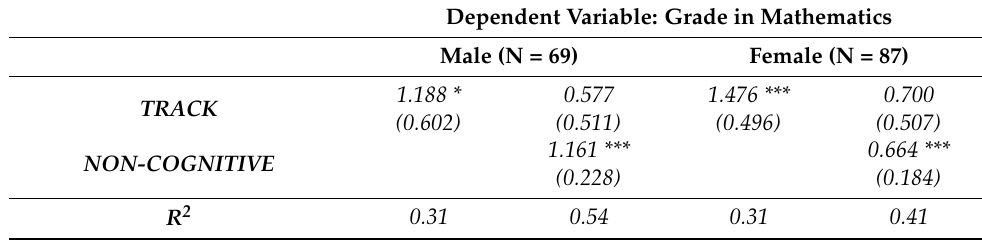
Dependent Variable: Grade in Mathematics Male (N = 69) Female (N = 87) 1.188 * 0.577 1.476 *** 0.700 (0.602) (0.511) (0.496) (0.507) 1.161 *** 0.664 *** (0.228) (0.184)